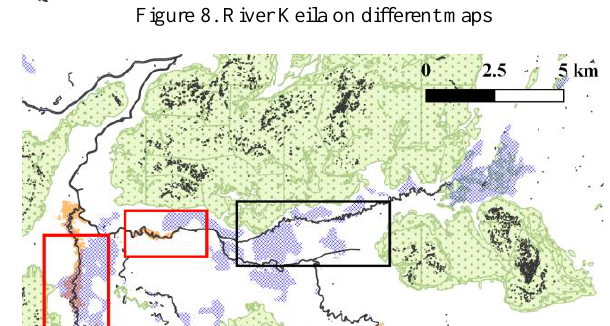
Figure 8. River Keila on different maps